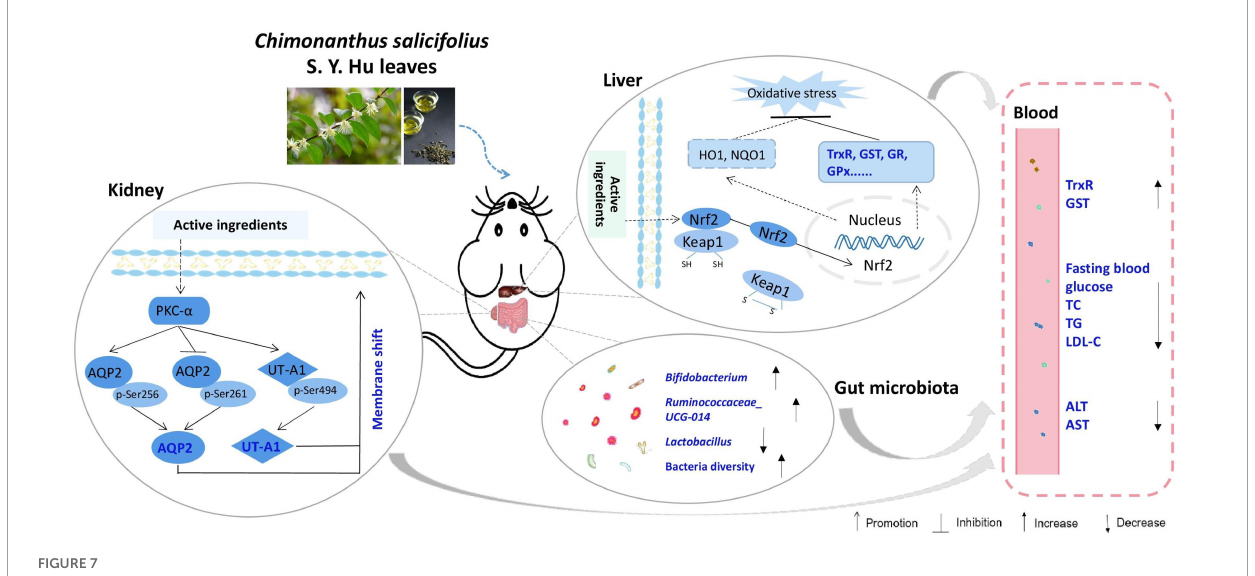
FIGURE7 Schematic diagram showing the underlying mechanisms of CHI leaves consumption on ameliorating metabolic syndrome.